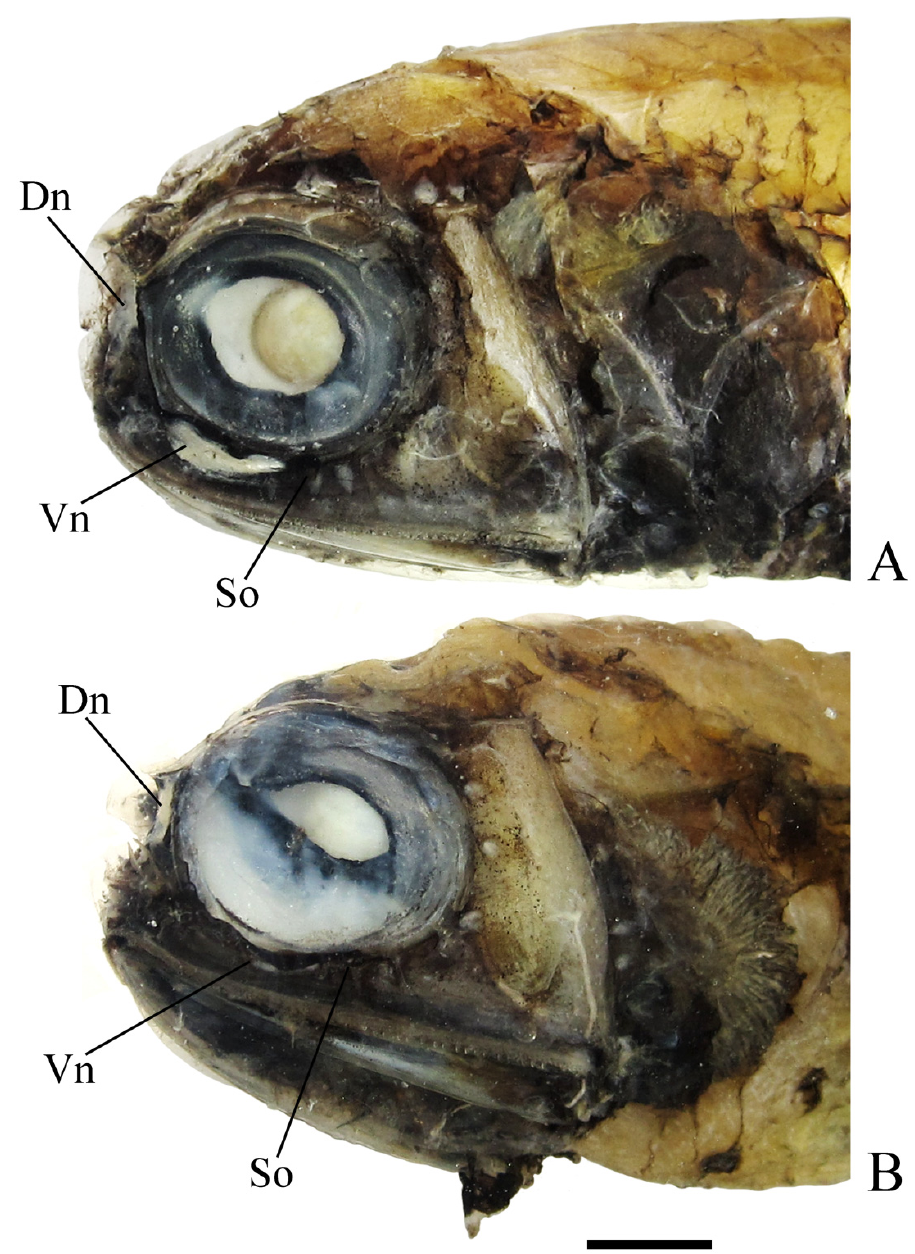
Figure 2. Diaphus balanovi sp. nov., luminous glands of the head (Dn, Vn and So). ( A ) Male, holotype, IORAS S.0124, 96 mm SL. ( B ) Female, paratype, IORAS S.0118, 96 mm SL. Scale bar: 5 mm. Otolith (based on four paratypes S.0118 of 88–90 mm SL) (Figure 3): Length × depth = 5.0–5.5 × 3.5–4.0 mm (ratio: 1.3–1.5). The predorsal rim is weakly to moderately